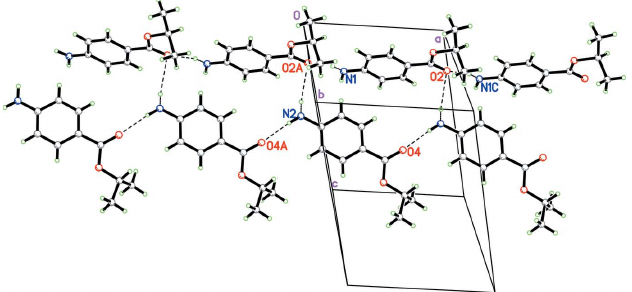
Figure 3 Partial packing diagram for I showing the formation of [100] double chains linked by N—H (cid:3)(cid:3)(cid:3) O and N—H (cid:3)(cid:3)(cid:3) N hydrogen bonds (shown as dashed lines).